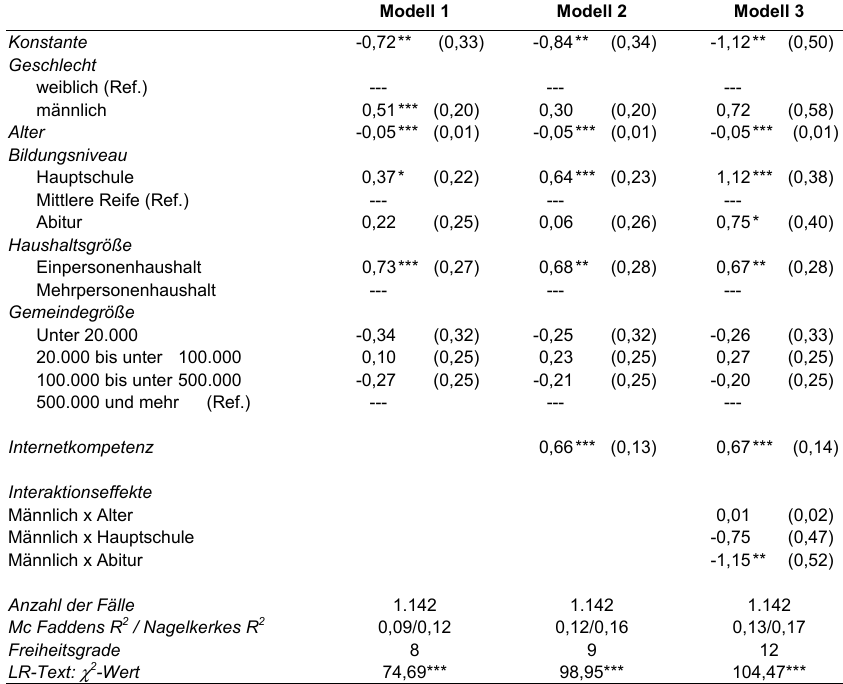
Tabelle 3: Logistische Regression der Determinanten der Nutzung von Internetkontaktbörsen (Regressionskoeffizienten, Standardfehler) Modell 1 Modell 2 Modell